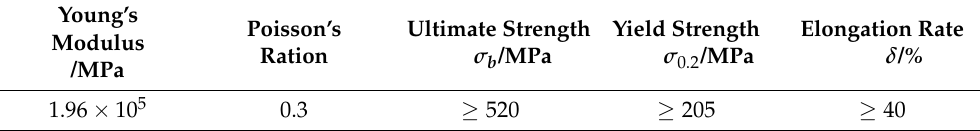
Table 1. Physical properties of 304 stainless steel.